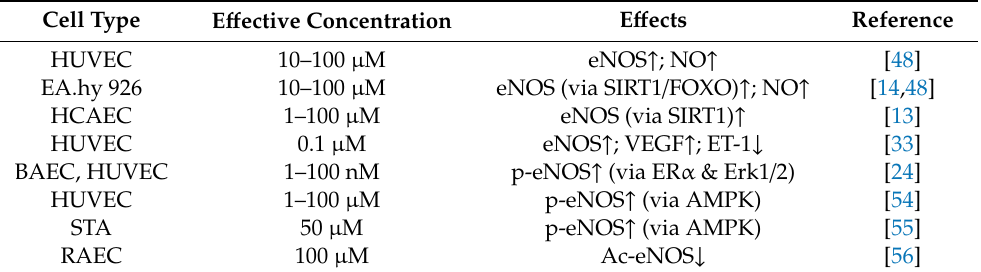
Table 1. Resveratrol increases NO production in endothelial cells.